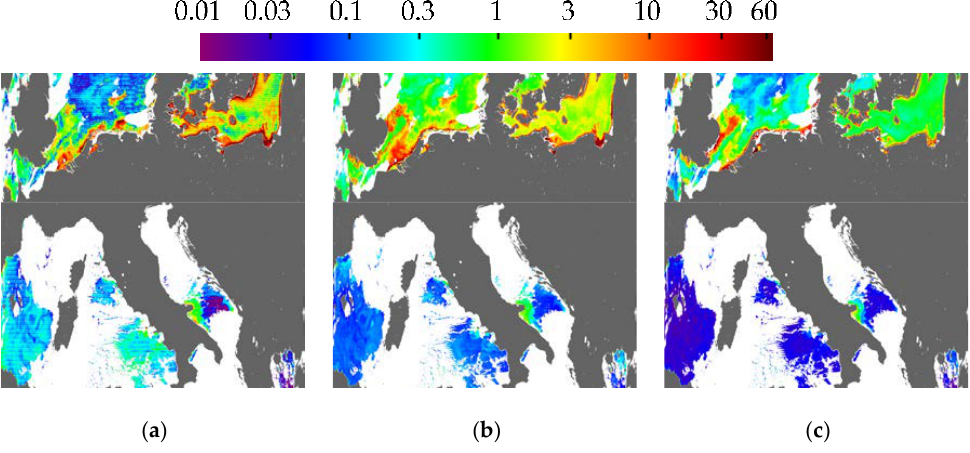
Figure 5. ( a ) Mean δln(chl), or bias; ( b ) standard deviation; ( c ) standard error.